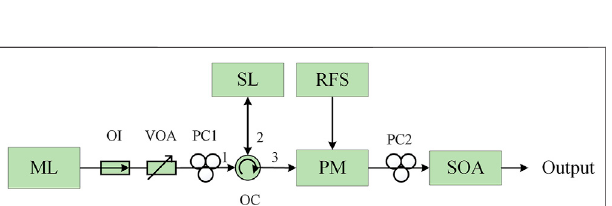
Frontiers in Physics |